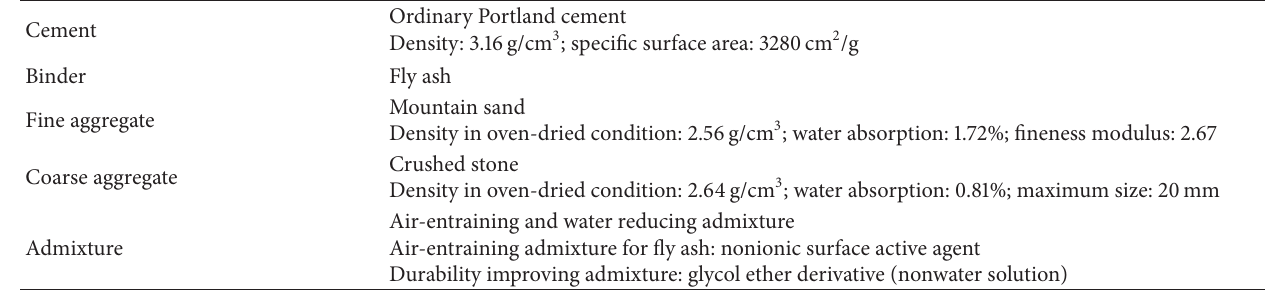
Table 1: Characteristics of materials used.